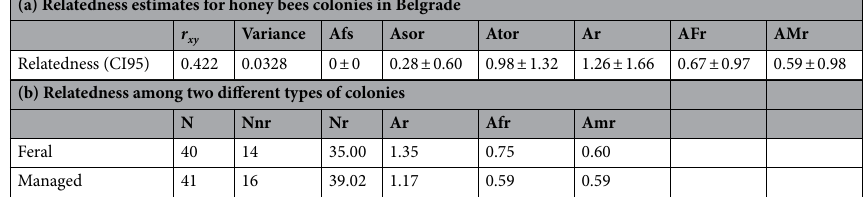
Table 3. Relatedness estimates for individual pairs of diploid individuals and average numbers of colonies that have full-sib, second-order, and third-order relationships for each colony in the sample and for both wild/ feral and managed colonies according to the TrioML estimator. (a) r xy —mean relatedness for individual pairs of diploid individuals; Afs—average number of full siblings per individual; Asor—average number of second- order relatives per individual; Ator—average number of third-order relatives per individual; Ar—average number of relatives (full-sib/parent–offspring relationships, second-order relationships and third-order relationships), AFr—average number of relatives in the sample of wild/feral colonies, AMr—average number of relatives in the sample of managed colonies. (b) N—number of colonies; Nnr—Number of colonies without related colonies; Nr—percentage of colonies that are not related with any other colonies; Ar—average number of related colonies per colony; Afr—average number of related feral colonies per colony; Amr—average number of related managed colonies per